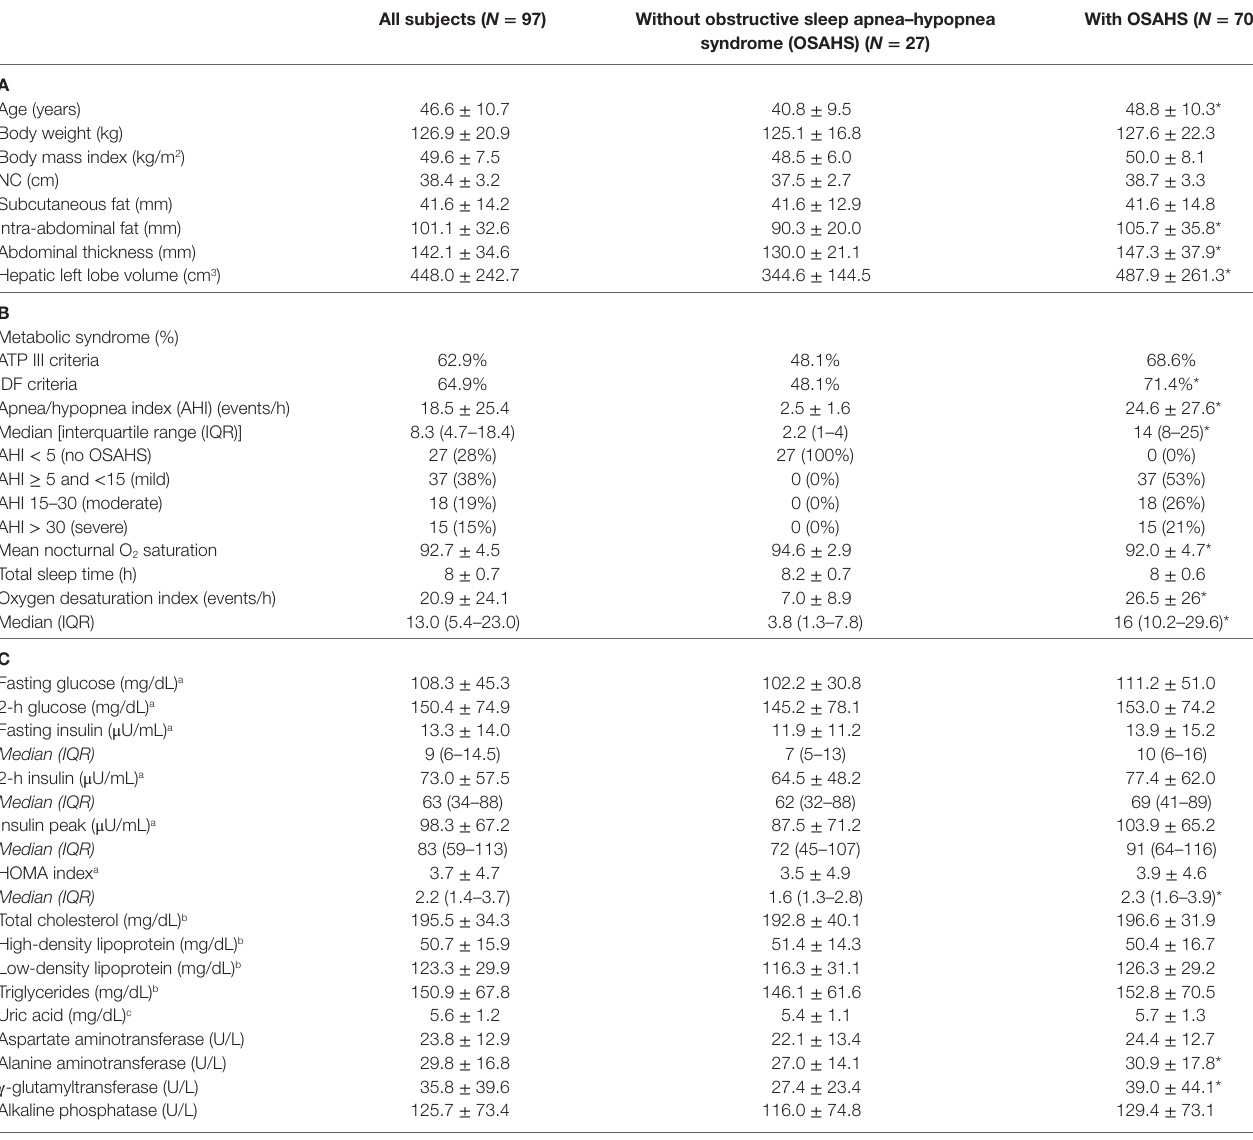
Table 1 | Demographic and anthropometric (A), clinical (B) and laboratory characteristics (C) of the study population. all subjects ( N = 97)